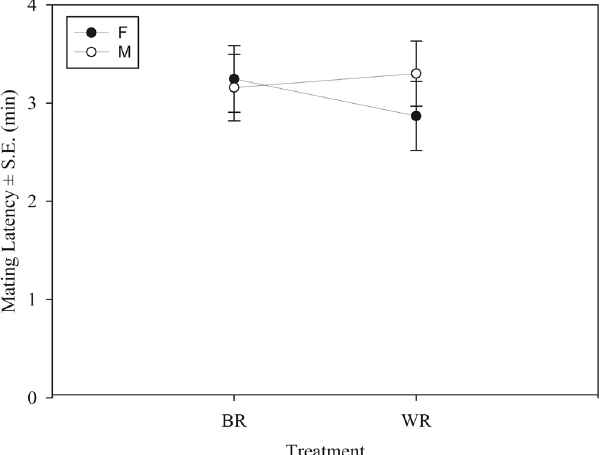
Figure 1. Mean mating latency ( ± S.E) of WR and BR treatments from female biased (F) and male biased (M) regimes based on the results of two-way ANOVA. There was no significant Selection Regime × Treatment interaction.